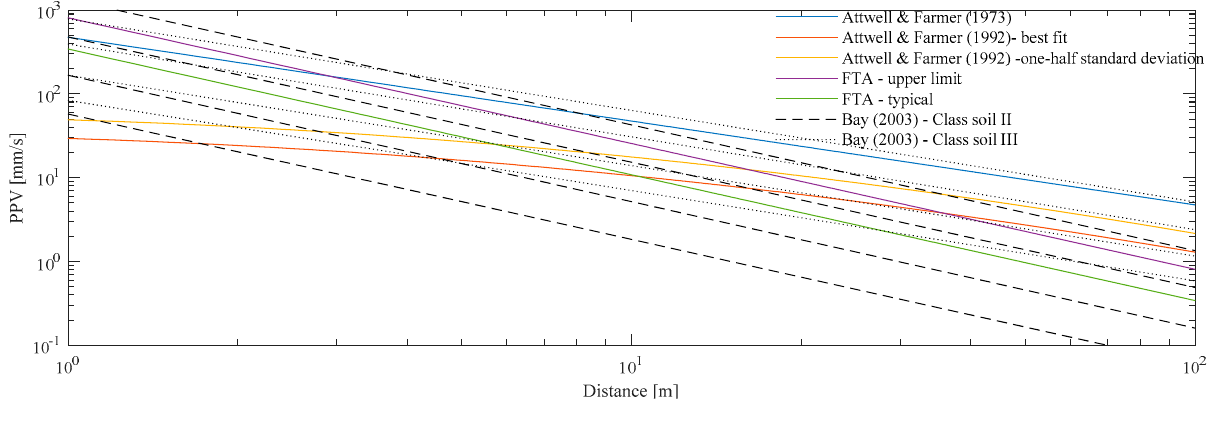
Figure 3. Empirical approaches.